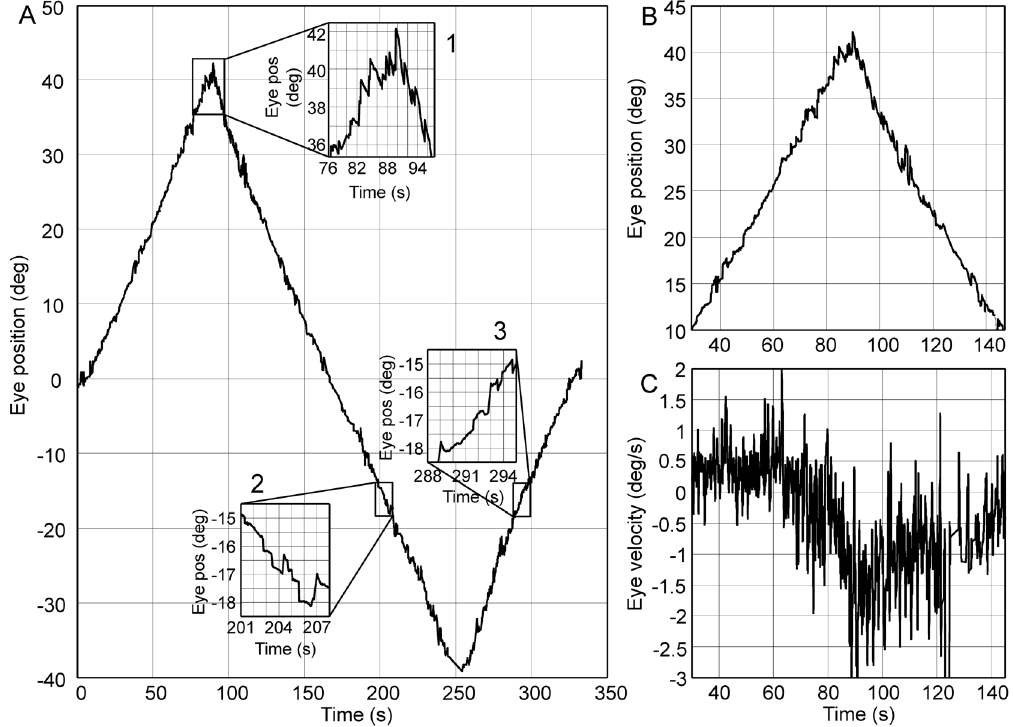
Figure 1. Raw data recorded in a single trial from a typical subject. Panel A - Left eye position plotted as function of time. Positive angles correspond to right eccentricities as seen by the subject. In this trial the dot was moving (0.5 deg/s) rightward at first. Inset 1: At extreme eccentricities the centrifugal beating nystagmus is clearly visible and the slow phase shows the tendency of the eye to return toward the primary position. Inset 2 and 3: Difference in the slope of the position trace at the same eccentricities when the dot is moving outward or inward. Panel B and C - Position (panel B) and velocity (panel C) of the eye at eccentricities larger than 10 deg right. The eye velocity begins to decrease from its baseline before the onset of the nystagmus, showing the growing centrifugal drift. Note that the baseline velocity is not zero but is positive between 10 and 25 deg of gaze eccentricity. When returning to 10 deg, however, the velocity is negative, showing the asymmetry in the baseline velocity showing the subject’s attempt to match the target displacement velocity. and 0.97 for the linear fit on the right and left side, 0.98 and 0.95 Using a paired Wilcoxon signed rank test we found that the slopes fitted from each subject for gaze eccentricities between 0 the right and left side, respectively. When evaluating the fit in the and 20 on one side were significantly (p , 0.05) smaller than those range 20–40 deg these values however dropped considerably for obtained in the same subject for gaze eccentricities between 20 and 40 deg on the same side. The median ratios (median absolute deviation in square brackets) of the paired slopes were 0.44 [0.29] on the left side and 0.32 [0.25] on the right side, respectively. Ratios of the slopes were significantly lower than 1 (p , 0.01), confirming the significant increase of the rate of growing of the eye drift velocity with gaze eccentricity and therefore indicating a non- linear behavior. Pooling both sides the median ratio was 0.41 [0.29]. The mean slopes of the fitted subjects are reported in The second analysis aimed at identifying a function that better represents the drift behavior, showing an improvement over the linear one. We characterized the behavior of the whole population by smoothing the individual instantaneous eye velocity traces of all subjects as a function of gaze eccentricity and interpolating them for all angles between 40 deg left to 40deg right in steps of 0.1 deg. Lilliefors test ([33]) confirmed that the obtained eye velocities at every step of interpolated eccentricity can be assumed to be normally distributed across subjects. We therefore calculated the mean eye velocity at each interpolated gaze eccentricity (figure 4) and fit each side with a linear, a tangent and a hyperbolic sine function (Eq. 1, Eq.2 and Eq.3, respectively). The variance- accounted-for evaluated in the range 0–20 deg scores were 0.90